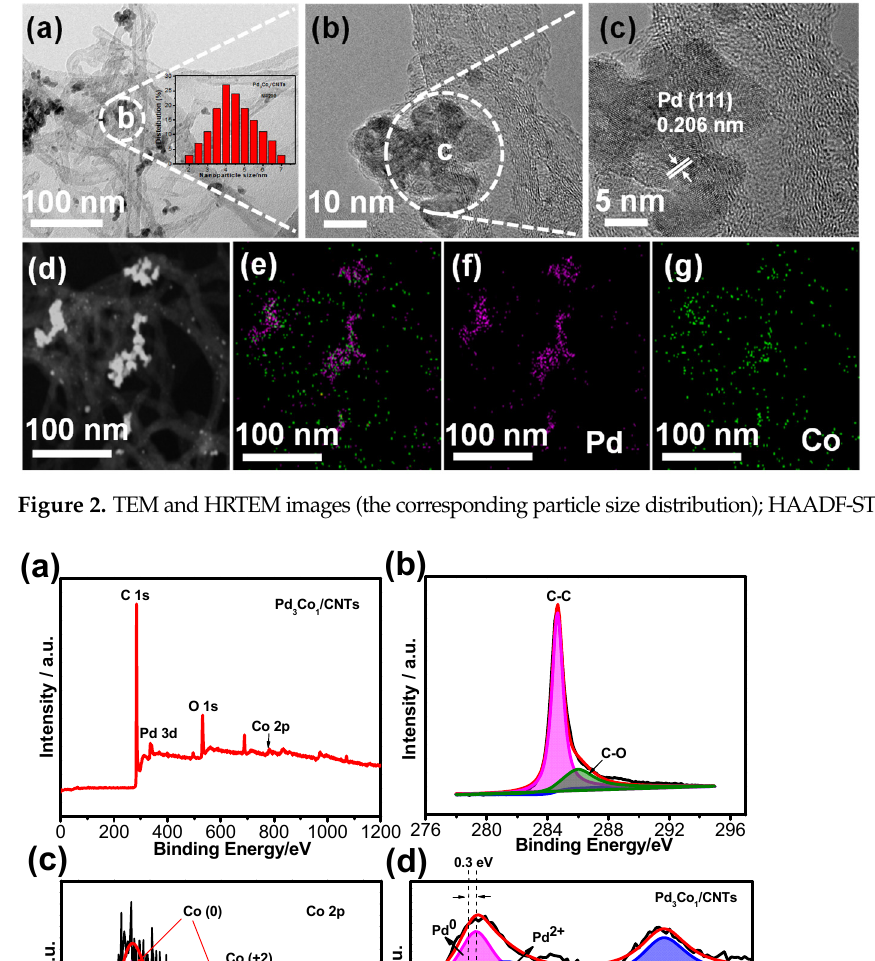
Figure 2. TEM and HRTEM images (the corresponding particle size distribution); HAADF-STEM elements.